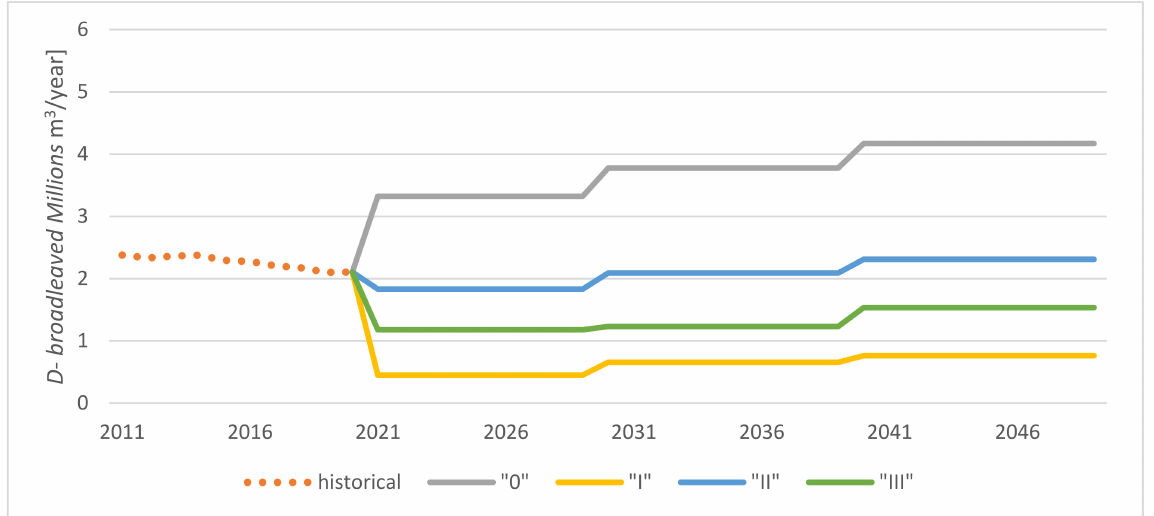
Figure 4. Change in the amount of broadleaved roundwood merchantable volume harvested in scenarios in light of historical levels of broadleaved roundwood merchantable volume harvesting.